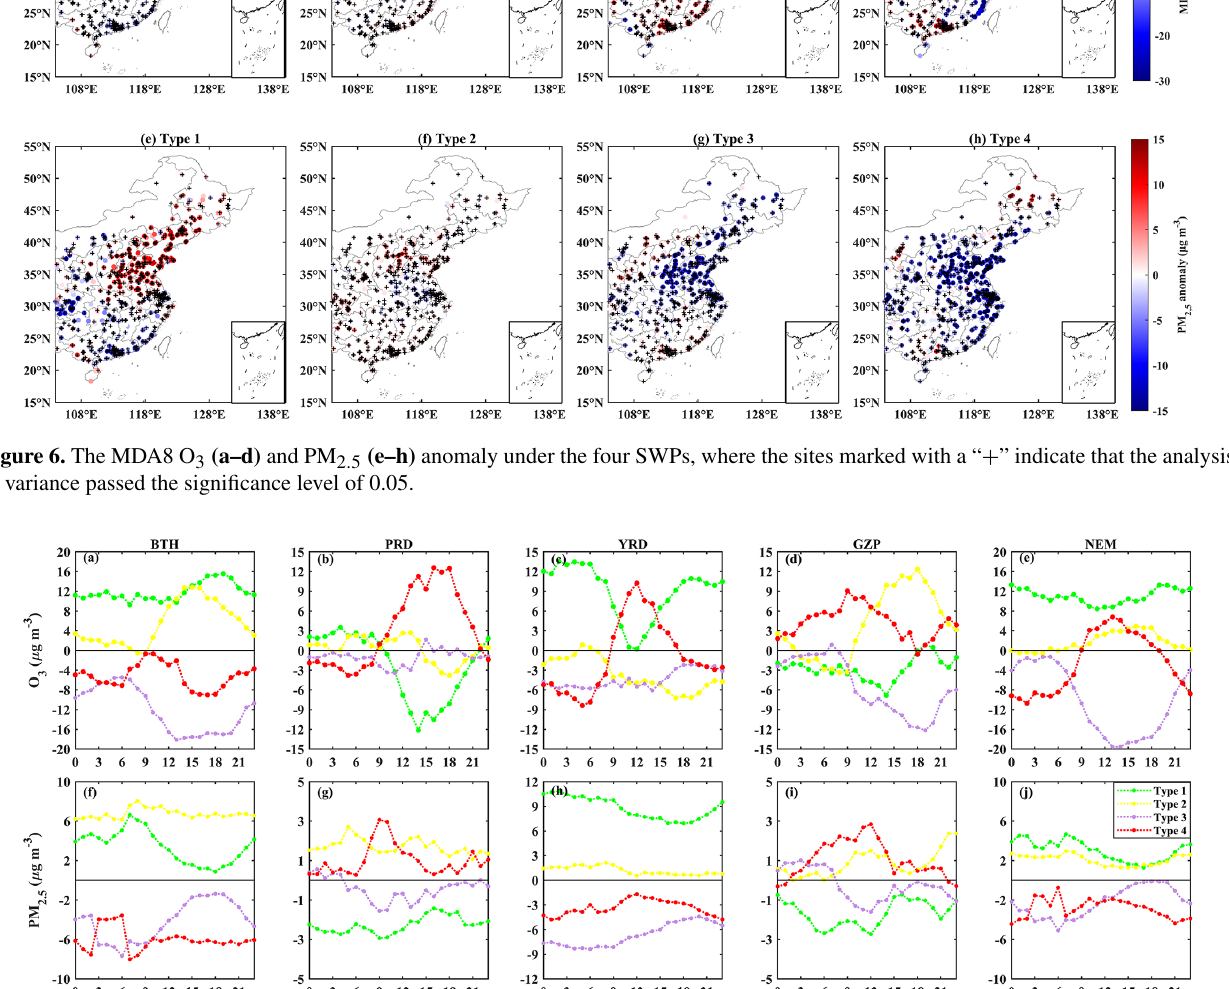
the northern boundary of the WPSH reached 37.5 ◦ N, and an occurrence of heavy precipitation across the western PRD region as well as central areas between the BTH and YRD regions under Type 4 (Fig. S9 in the